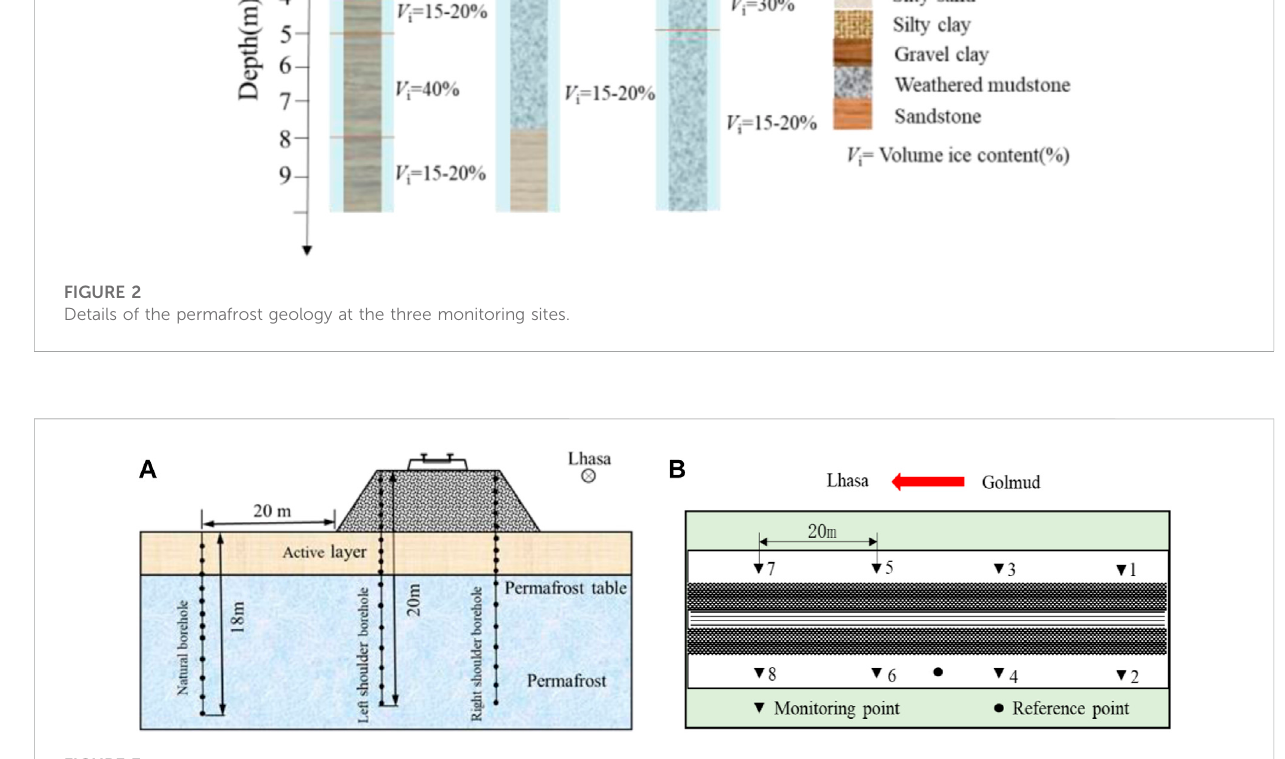
settlement value of the left shoulder ranged from 87 mm